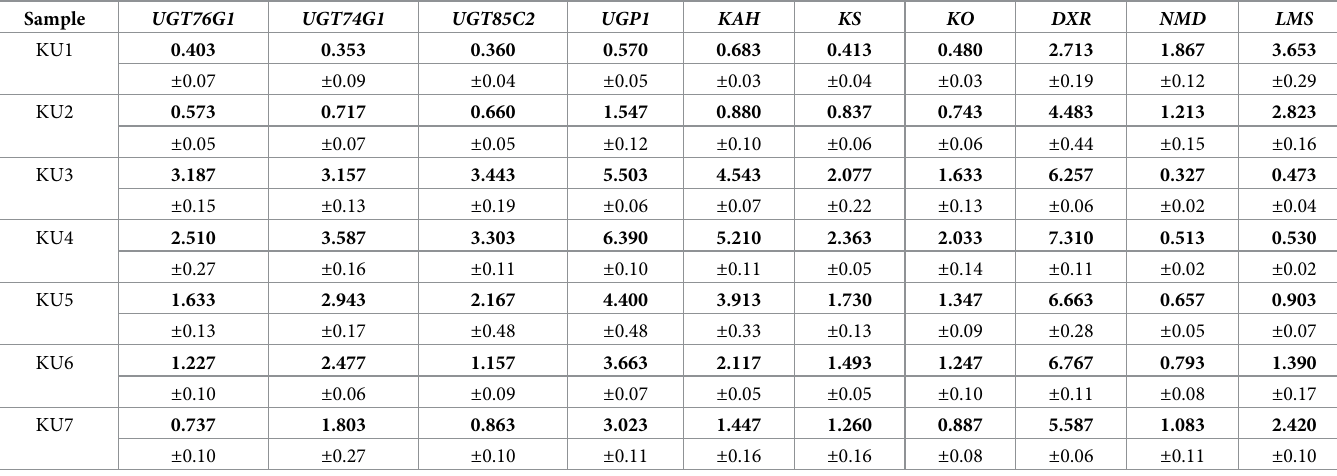
The fold change in expression of the target gene relative to the internal control gene ( SrGAPDH and SrUBI ) in seven transgenic lines was studied. The samples were analyzed using real-time quantitative PCR.